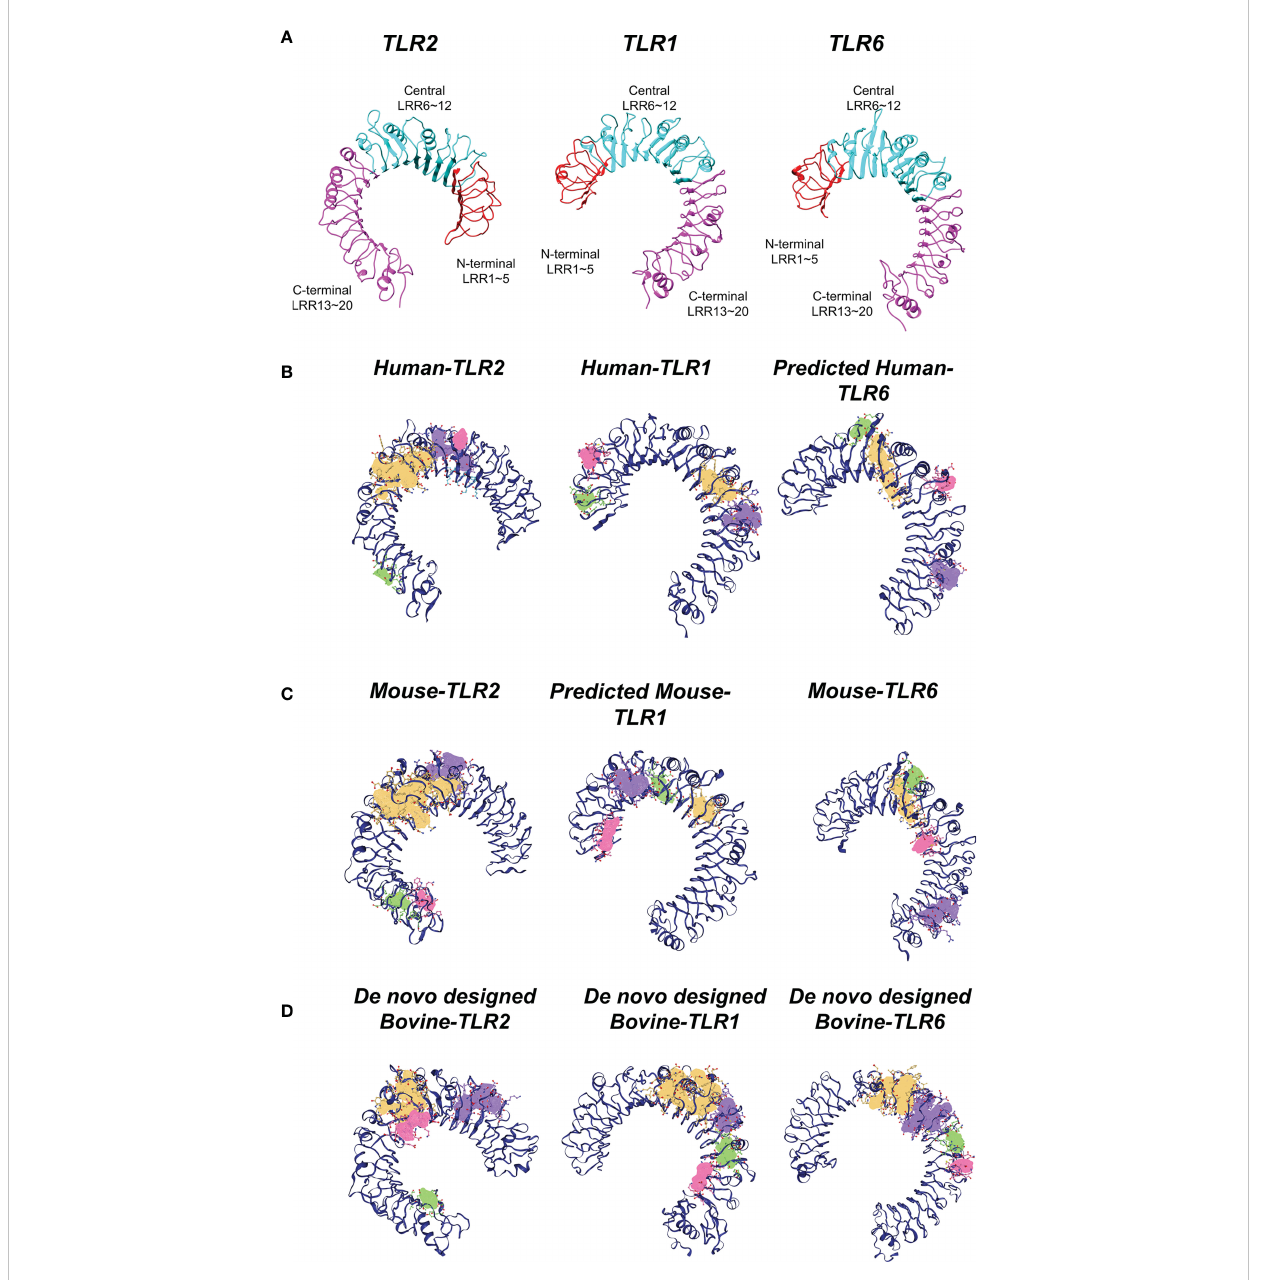
FIGURE 6 Structural analysis of TLRs in three mammalian classes (human, mouse, bovine). (A) Three subdomains of TLRs having 20 LRR units, namely N- terminal (LRRNT), central and C-terminal (LRRCT) in the ectodomain of TLRs. LRRNT (LRR 1~5), central (LRR 6~12) and LRRCT (LRR 13~20) colored by red, cyan and magenta, respectively. (B) Predicted potential binding pockets of human TLRs. C) Predicted potential binding pockets of mouse TLRs. (D) Predicted potential binding pockets of bovine TLRs. Different potential binding pockets of TLRs are shown by yellow ( fi rst pocket), violet (second pocket), green (third pocket), red (fourth pocket). The main binding site (yellow pocket) of TLR2 is similar (localized between LRR9-12, and the entrance is in LRR11-12) in the three species. Concerning TLR1, the main binding site (yellow pocket) is between central and LRRCT domains for all species. However, this internal channel is blocked by two phenalene in